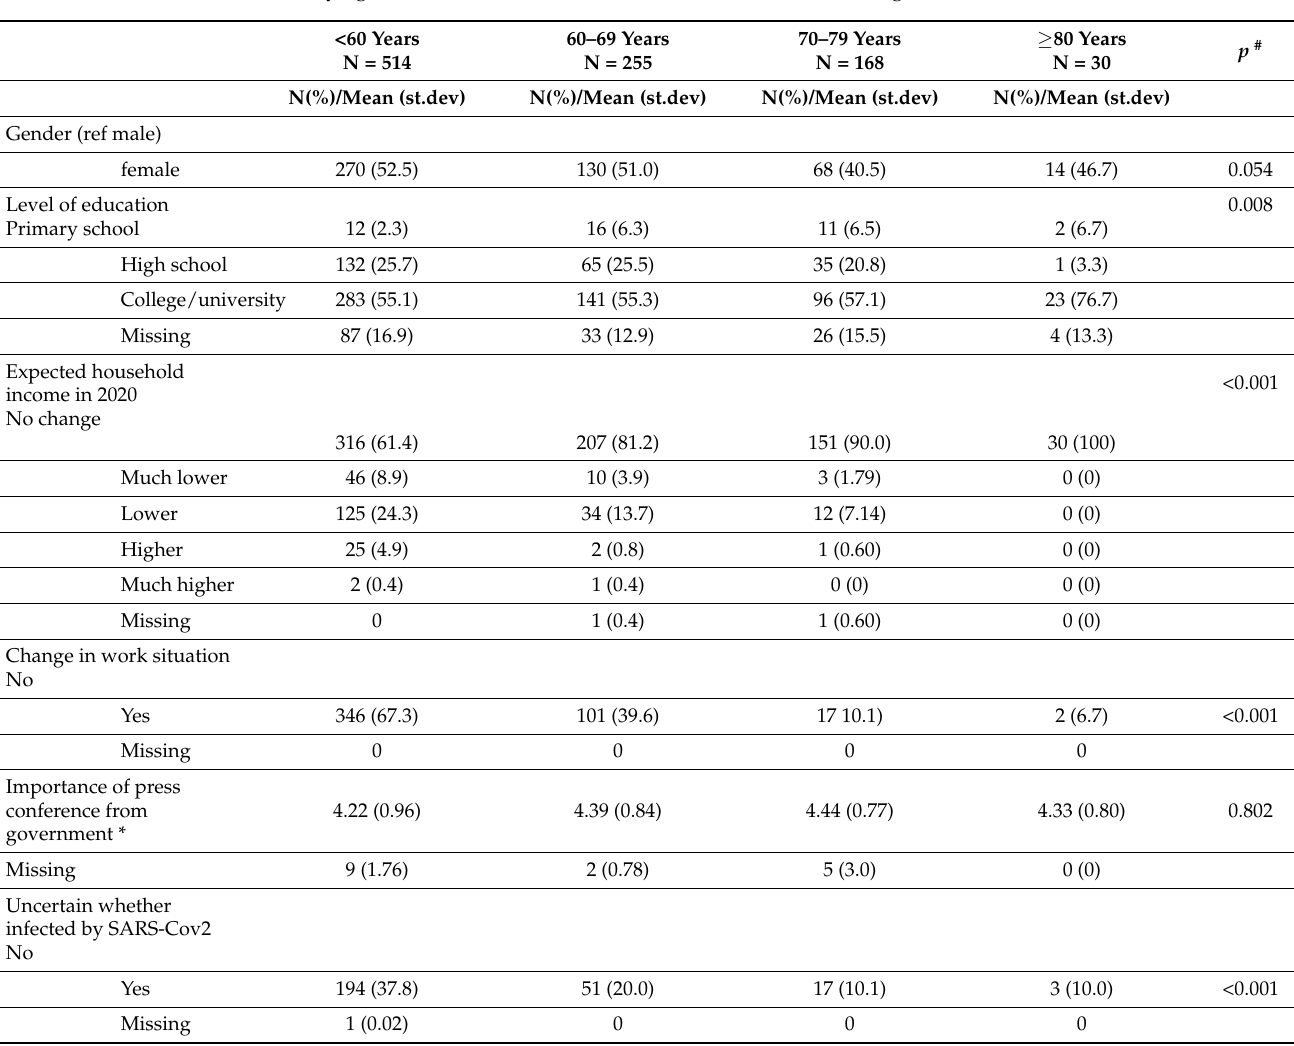
Table A1. Variables by age in the COVID-19 wave in March 2020 of the Norwegian Citizen Panel (N =